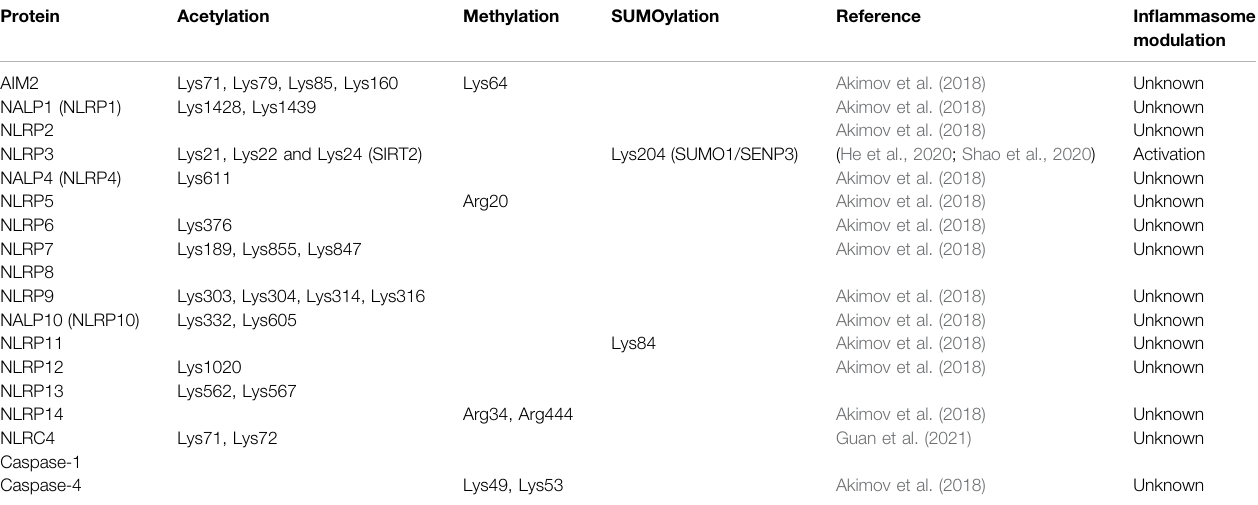
TABLE3| Summaryofhumanin fl ammasomeotherlesscommonPTMs.InorangearerepresentedresiduesnonvalidatedbyrecordedinPhosphositePluswhereasingreen are validated